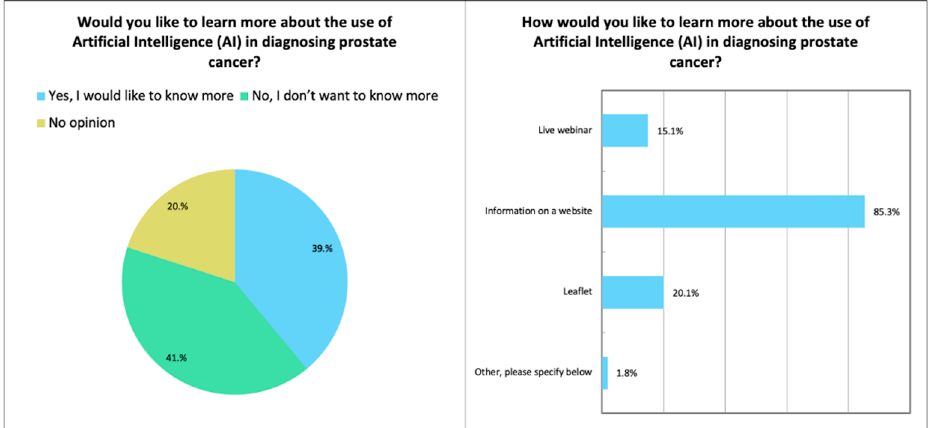
Figure 5. Visual representation of respondents’ views on whether they would like to be further in- formed about AI in the diagnosis in prostate cancer and the preferred format (please see online supplementary material, Question